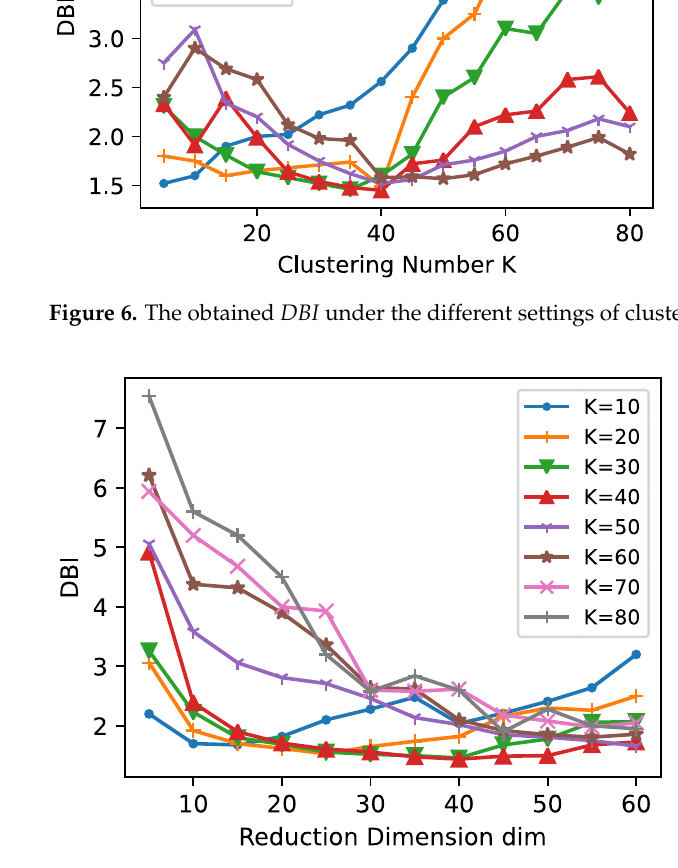
[10,40] K ∈ , first, the DBI value decreases, and then [50,80] K ∈ , the DBI value decreases with an